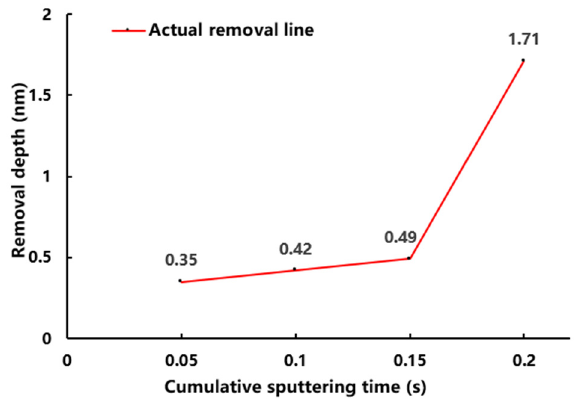
Figure 3. ( a ) Initial coating section; ( b ) after 15 pulses.